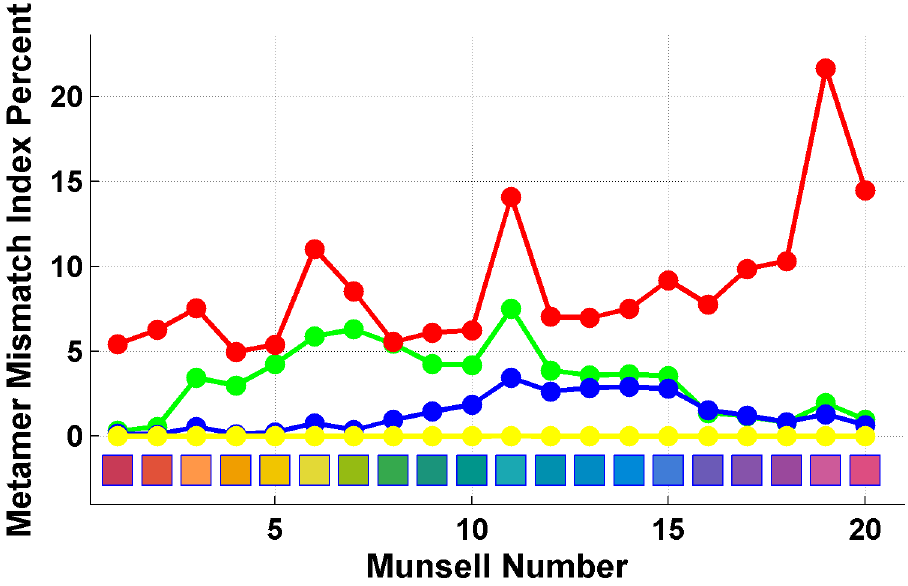
Fig 6. Metamer mismatch indices in percent (from Table 1) for the shift from the neutral to a coloured illuminant. The marker colour indicates the colour of illuminant. The abscissa is the number of the corresponding Munsell paper from Fig 2